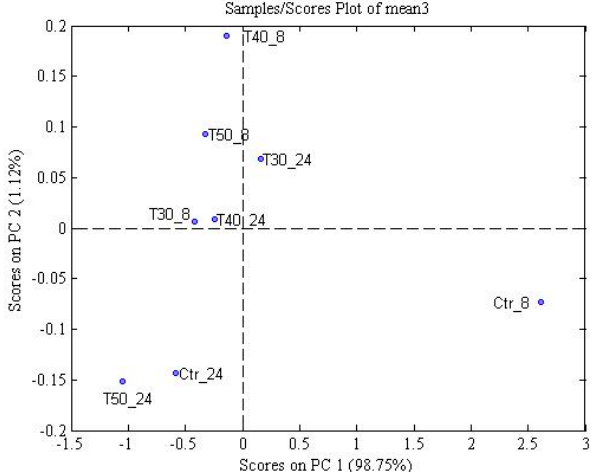
Figure 4. Principal component analysis score plot of pineapple core FT-IR spectra of the control (Ctr) and heat-treated (T) core pineapple wounded samples, stored at 5 ± 1 °C for 8 h (_8) and 24 h (_24). T30_8: heat-treated at 30 °C for 15 min and stored at 5 ± 1 °C for 8 h; T30_24: heat-treated at 30 °C for 15 min and stored at 5 ± 1 °C for 24 h; T40_8: heat-treated at 40 °C for 15 min and stored at 5 ± 1 °C for 8 h; T40_24: heat-treated at 40 °C for 15 min and stored at 5 ± 1 °C for 24 h; T50_8: heat-treated at 50 °C for 15 min and stored at 5 ± 1 °C for 8 h; T50_24: heat-treated at 50 °C dur for ing 15 min and stored at 5 ± 1 °C for 24 h.